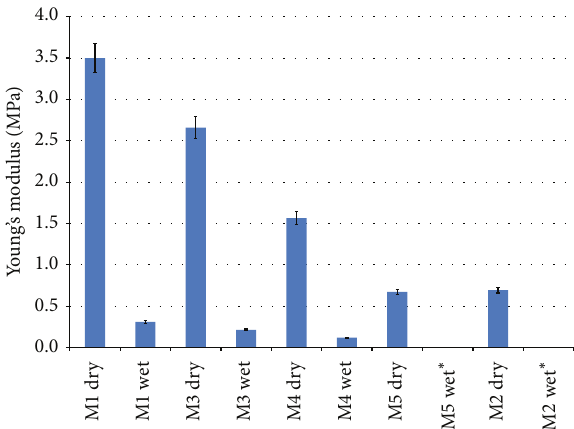
Figure 5: Influence of MCCh and Fb content on Young’s modulus ( E ) of membrane